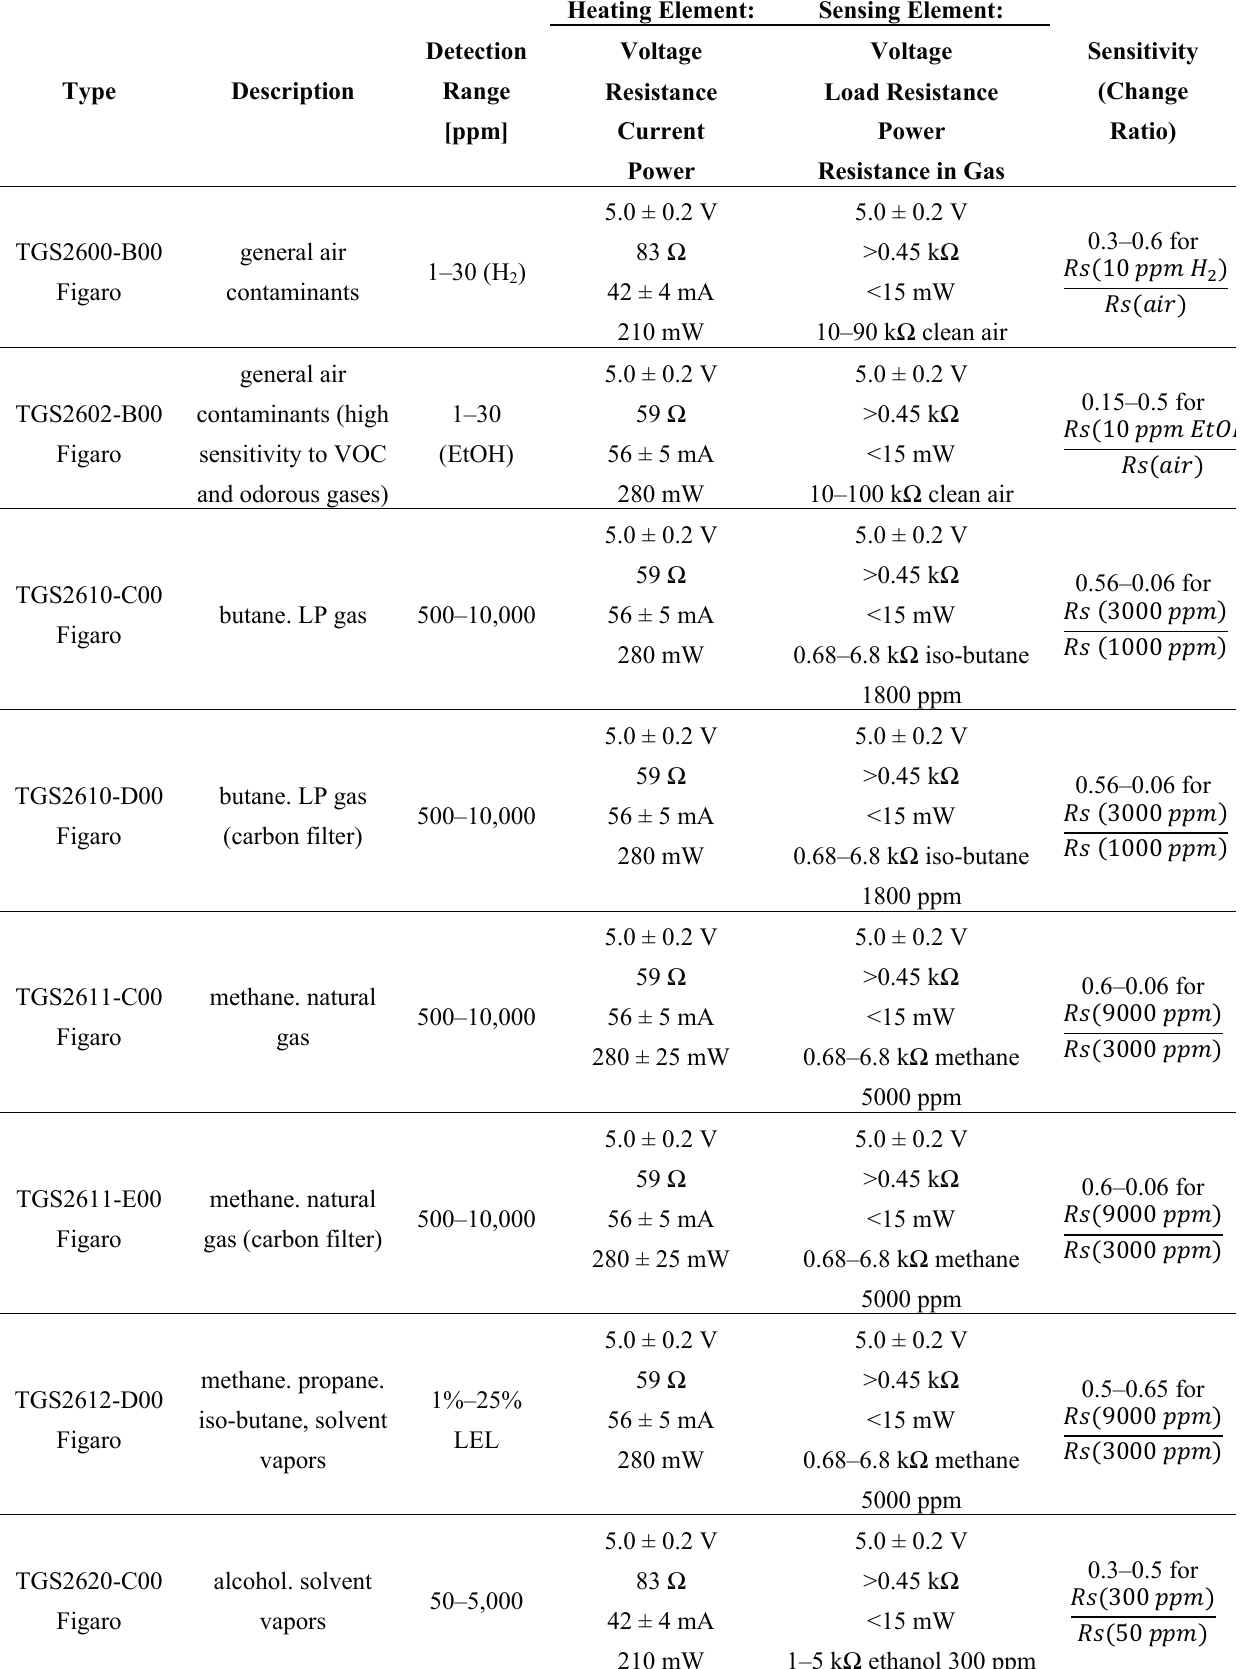
Table 3. Overview of the gas sensors implemented in the e-nose [46].